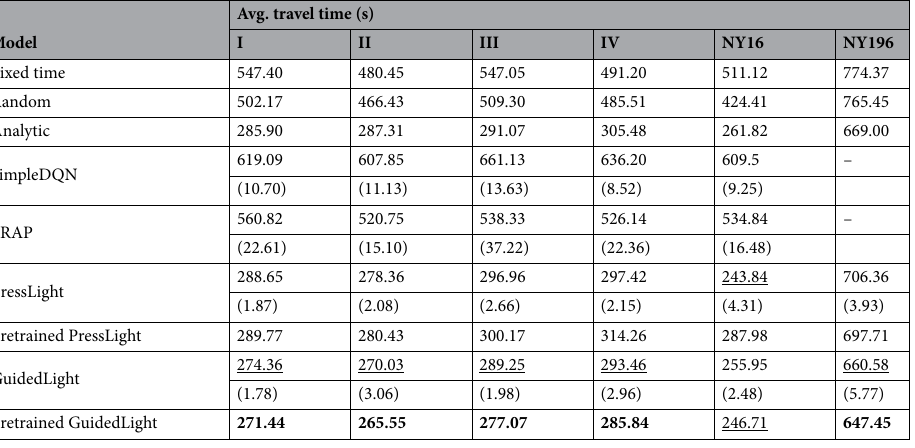
Table 2. Average travel time of different traffic signal control methods for 4 configurations of 4 × 4 synthetic scenario and two real-world based scenarios. The values in brackets are standard deviations of the last 10 training epochs. Pretrained methods do not include standard deviations as they are trained and tested on different scenarios. Best results are presented in bold, second best are underscored. The NY196 scenario has not been run with FRAP and Simple DQN as the implementation of these agents is prohibitively slow and energy consuming for large scenarios 50